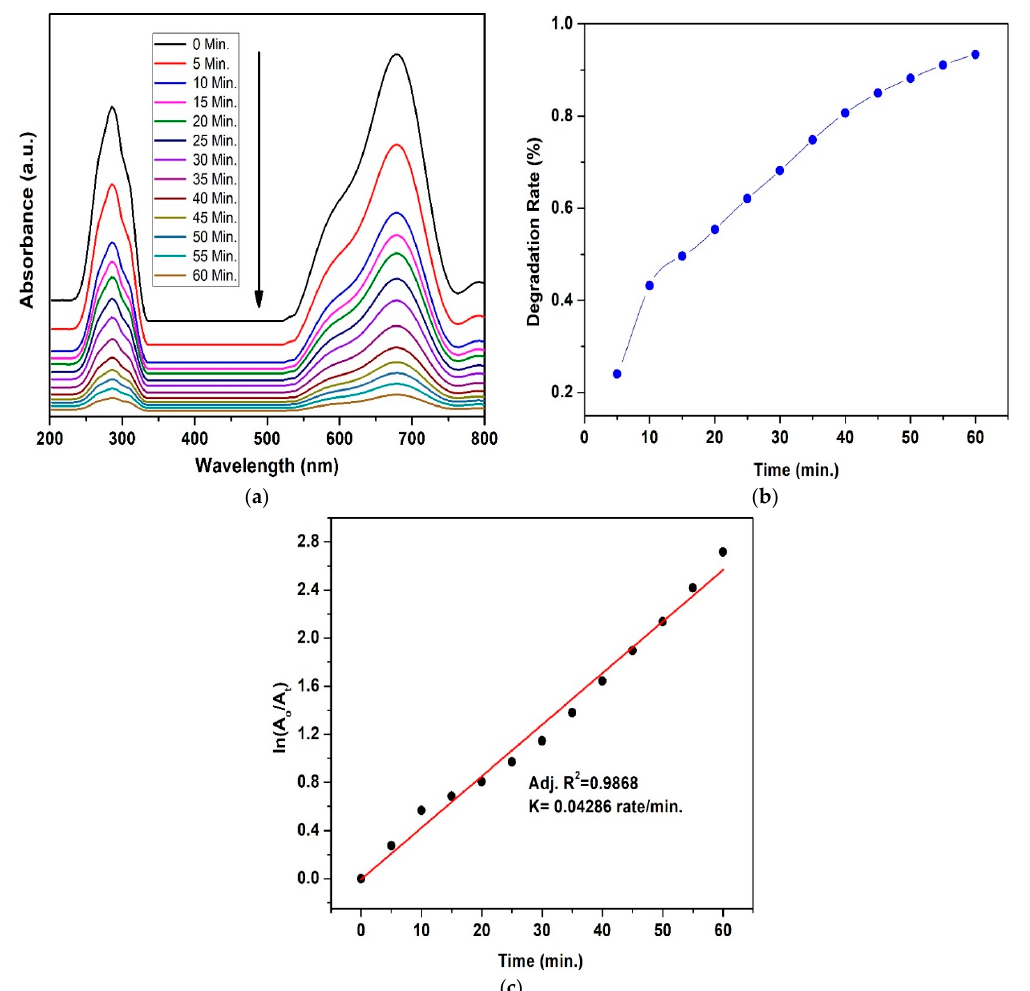
Figure 10. Photocatalytic activity of MB in presence of Co 0.4 Cu 0.6 Fe 2 O 4 nanoparticles irradiated by visible light for 60 min: ( a ) UV–Vis. Spectra, ( b ) Degradation rate in % and ( c ) kinetics of degradation.